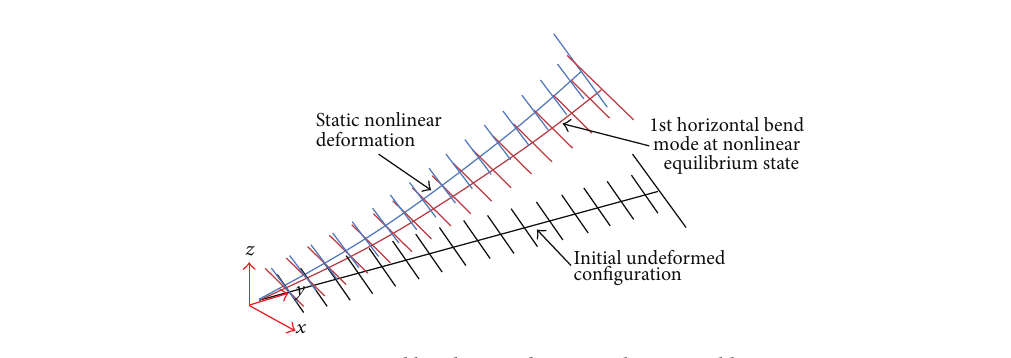
Figure 17: 𝑉 - 𝐹 and 𝑉 - 𝑔 curves of the linear flutter analysis.